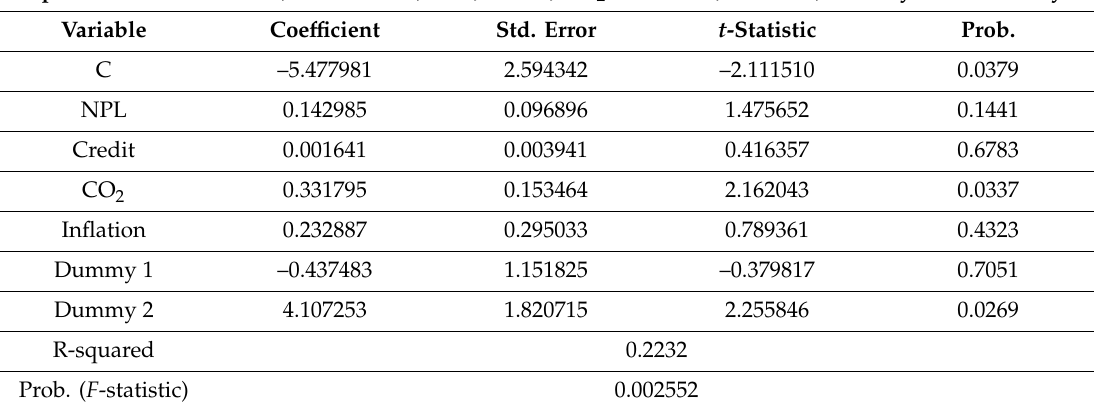
Table 13. Panel Fully Modified Ordinary Least